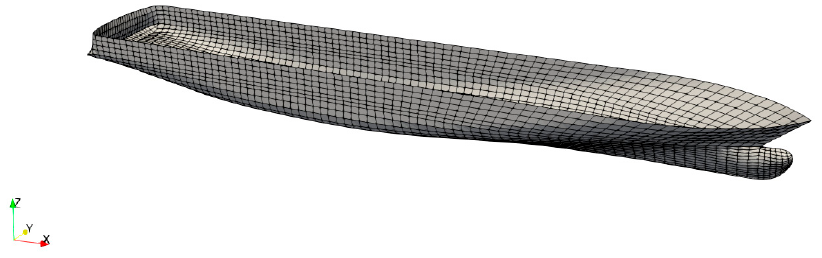
Figure 3. Hydrodynamic mesh (3192 hydrodynamic panels).